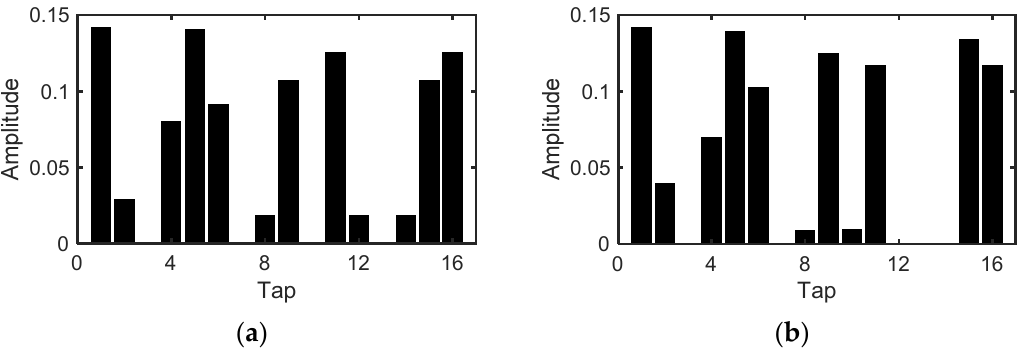
Figure 16. Simulated sensor output, 𝒑′ without shot noise: ( a ) 𝑑 (cid:2869) = 16 m, 𝑑 (cid:2870) = 26 m. ( b ) 𝑑 (cid:2869) = 17.96 m, 𝑑 (cid:2870) = 24.39 m. They look very similar.